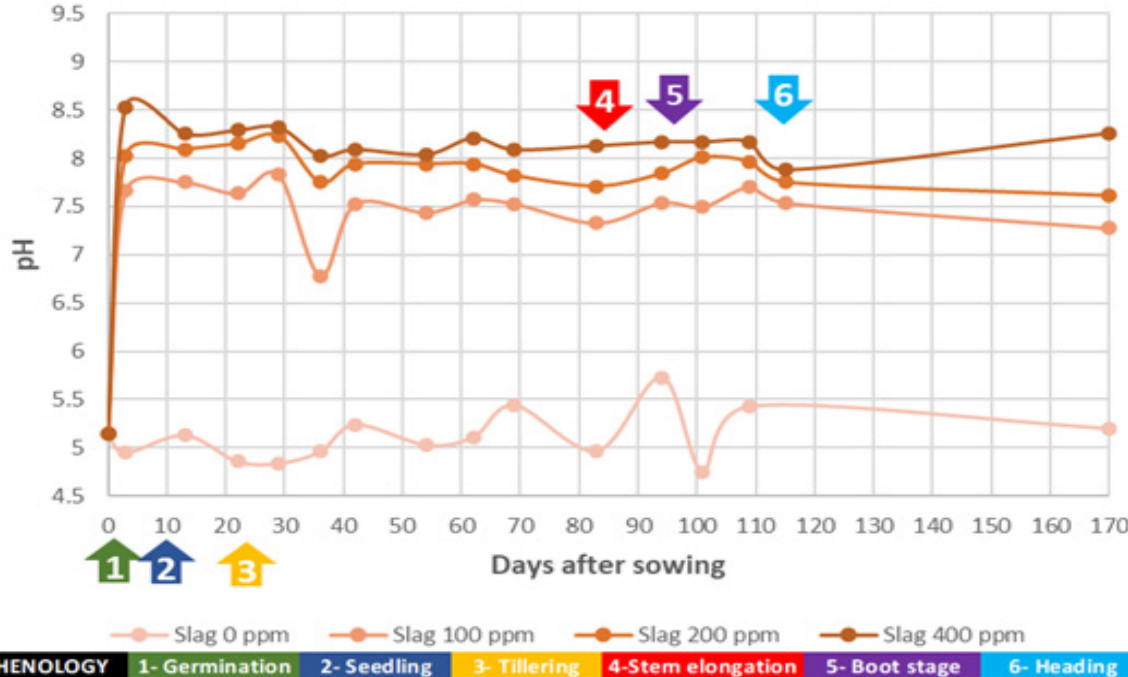
Figure 5 . Fluctuation of soil pH for all ladle furnace slag treatments (Slag Xppm) during the field stage of the